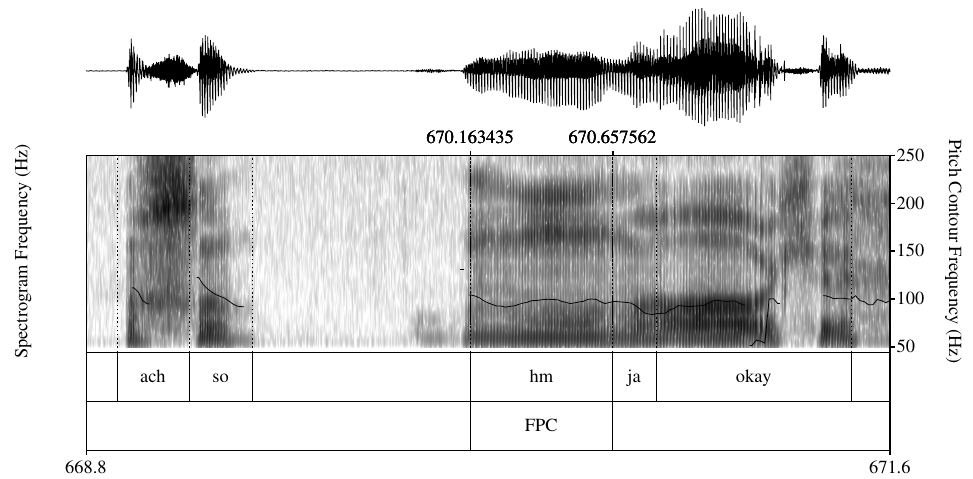
Figure 11. Example of hm (494ms) as filler particle candidate in ach so <pause> hm ja okay ‘I see <pause> hm yeah okay’ (source g_frei_m5).